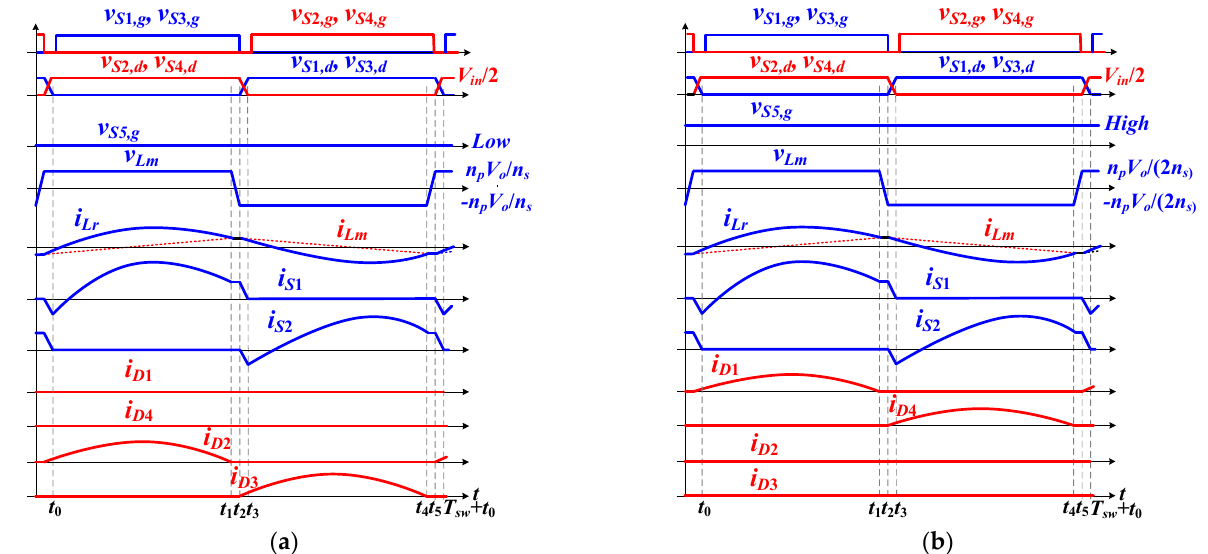
Figure 2. Circuit configuration of ( a ) presented DC/DC converter at ( b ) low voltage output and ( c ) high voltage output.